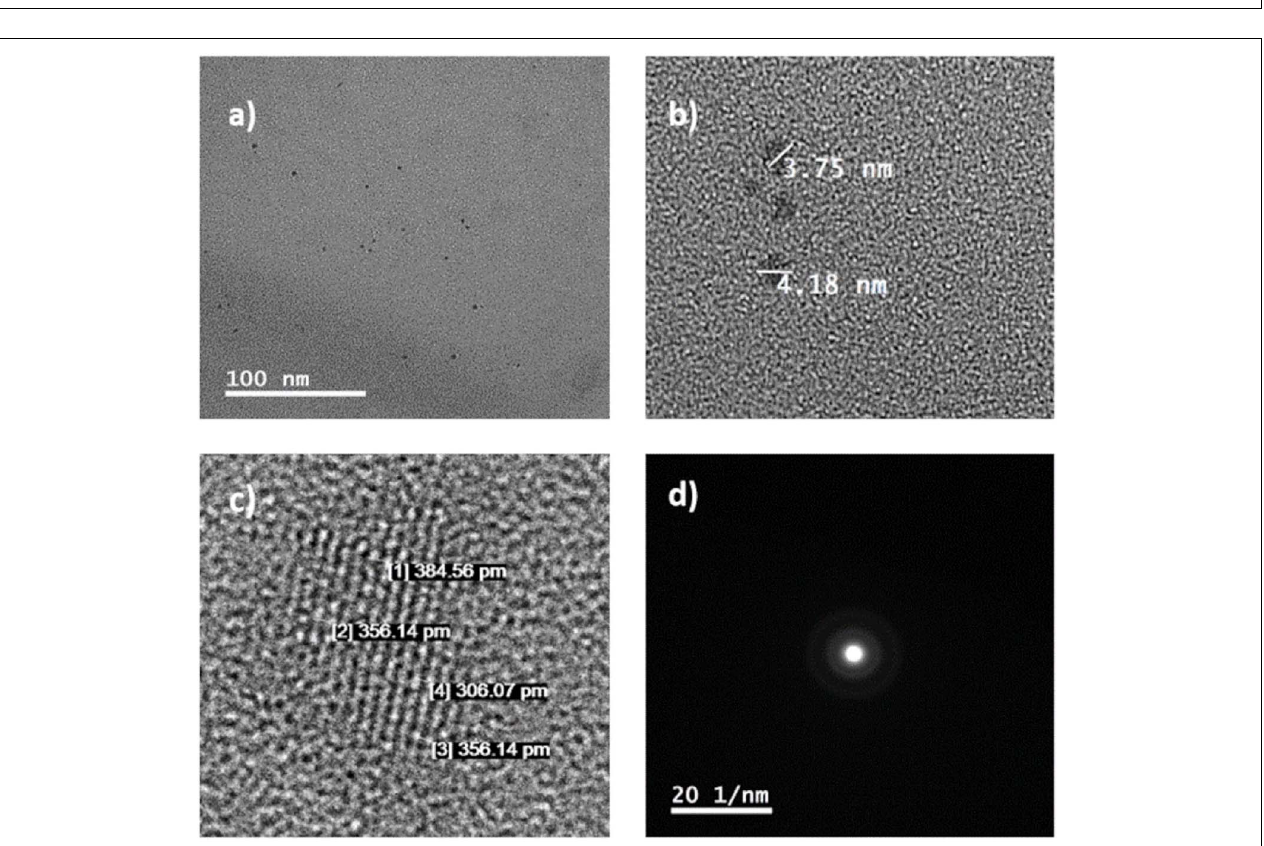
FIGURE 2 | (a,b) C-DOTS TEM images. (c,d) High-resolution TEM images and corresponding 2D FFT image.